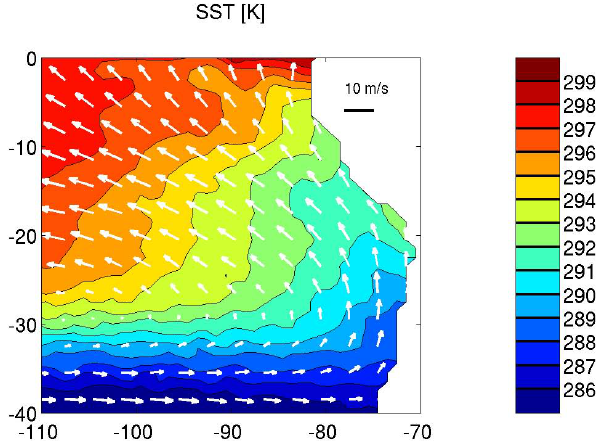
Fig. 1. October 2006 mean AMSR-E SST(K) and QuikSCAT winds (10ms − 1 scale plotted).